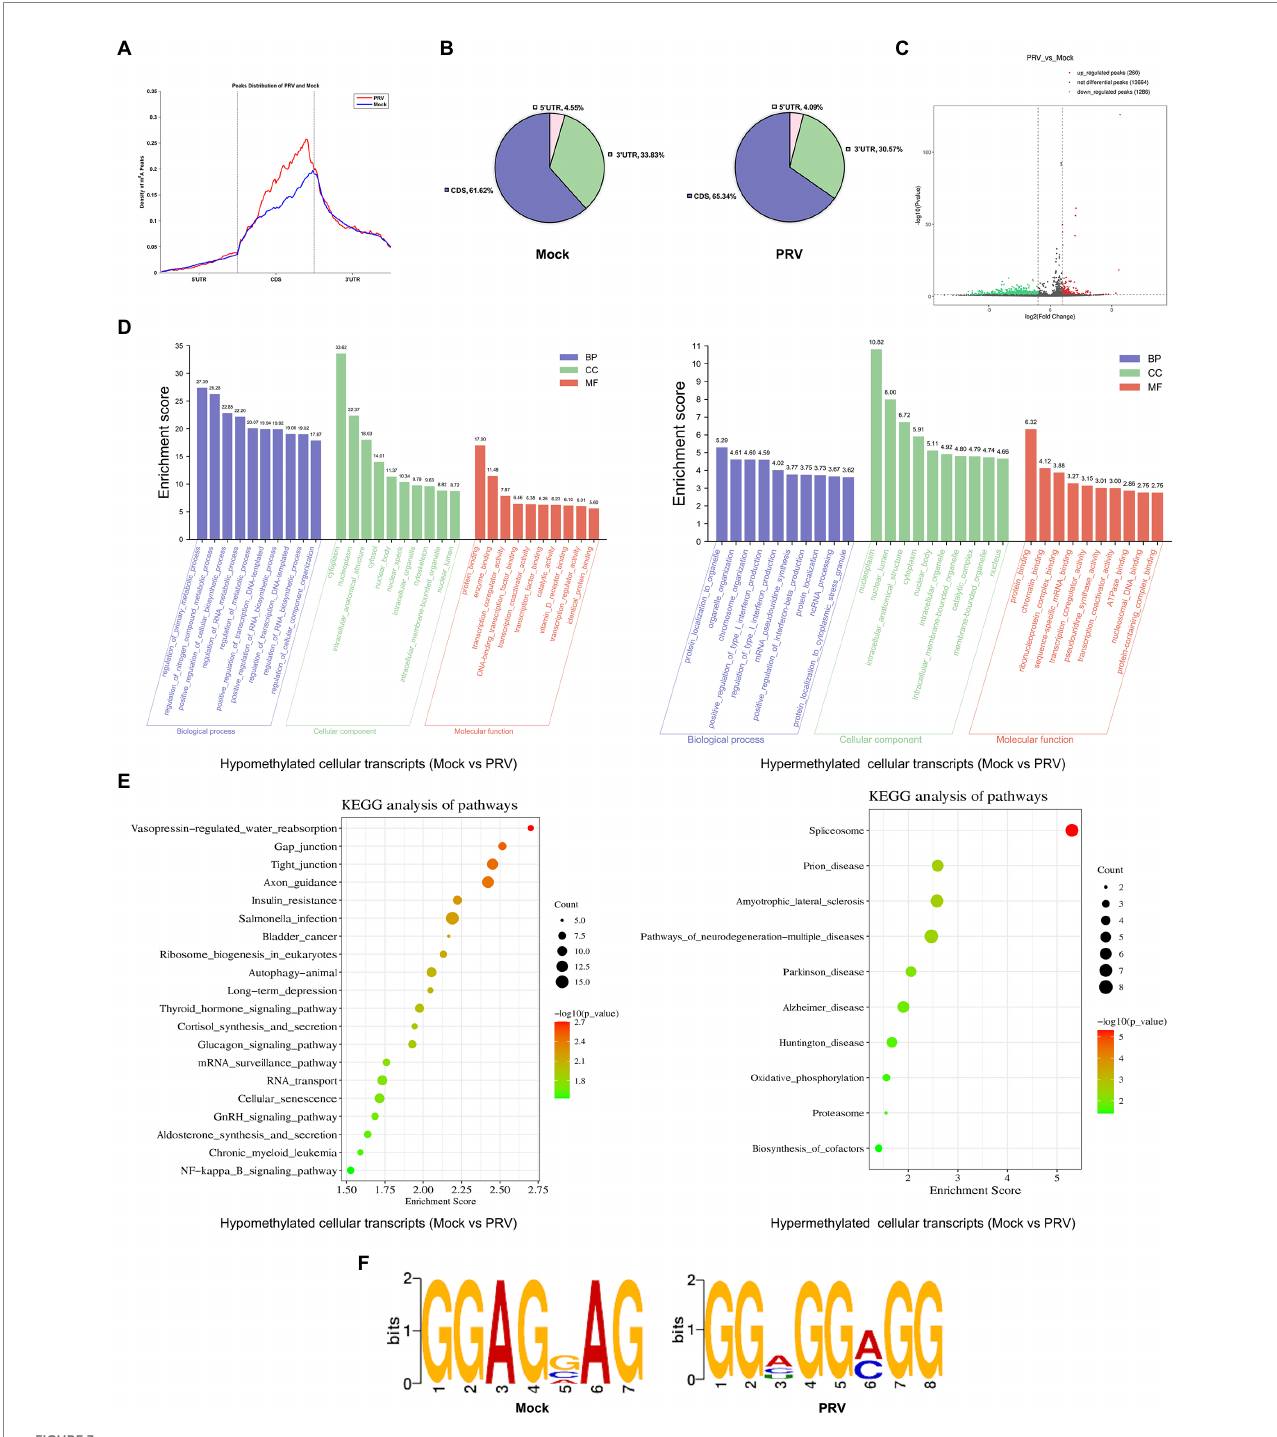
FIGURE 3 PRV infection influenced m 6 A methylome of PK15 cell transcripts. (A) MeRIP-seq of PK15 cells which were infected by PRV (or uninfected as a negative control, i.e., “Mock”) for 24 h. Density of m 6 A peaks on PRV-infected and uninfected cellular transcripts. The m 6 A peaks information was included in our MeRIP-seq data (NCBI #GSE209949). (B) Distribution pattern of m 6 A peaks on PRV-infected (right) and uninfected (left) cellular transcripts. (C) Volcanic map of m 6 A peaks (left was downregulated, right was upregulated by PRV infection). There were 1,286 significantly down-regulated m 6 A peaks, and 260 significantly up-regulated m 6 A peaks induced by PRV infection. (D) GO enrichment analysis of pathways enriched in the hypomethylated (left) and hypermethylated (right) genes (The top 30 enriched pathways are shown.). (E) KEGG analysis of pathways enriched in the hypomethylated genes (left, the top 20 enriched pathways are shown.) and the hypermethylated genes (right, the top 10 enriched pathways are shown.). (F) Motif analysis to identify consensus sequences for PRV-infected (right) and uninfected (left) PK15 cells transcripts. The most prominent motif for each was